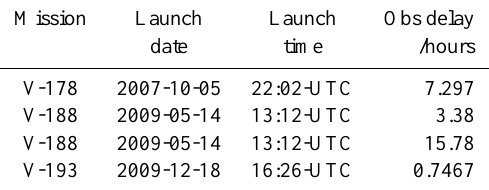
Table 2. Ariane 5 launches which appear to coincide with MLS observations of enhanced water vapour. A launch that was observed by MLS appears once for each MLS orbit on which it was observed. The “Obs delay” column is the number of hours between the launch time and the MLS